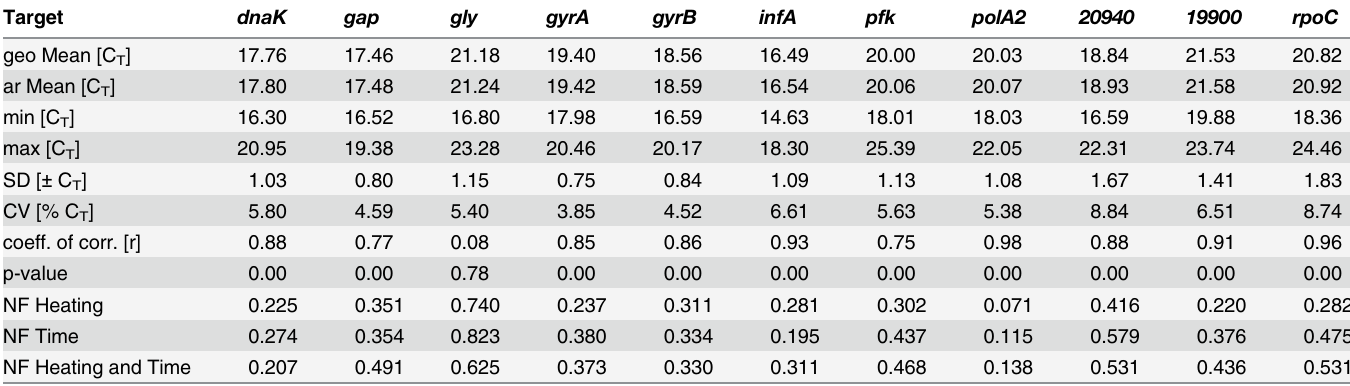
Table 5. Descriptive statistics and stability values of candidate reference genes under different heating methods (oven or microwave) ( n = 16). Target